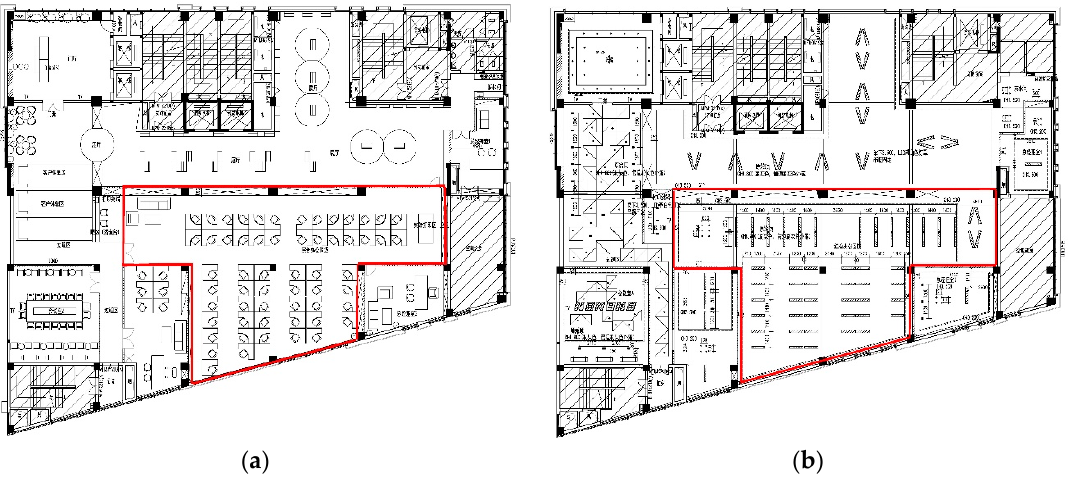
Figure 13. Floor plan and layout of luminaires: ( a ) floor plan of the office and ( b ) layout of luminaires, each of which was equipped with a sensing module. Table 6. Specifications of the luminaires in scenario 2.